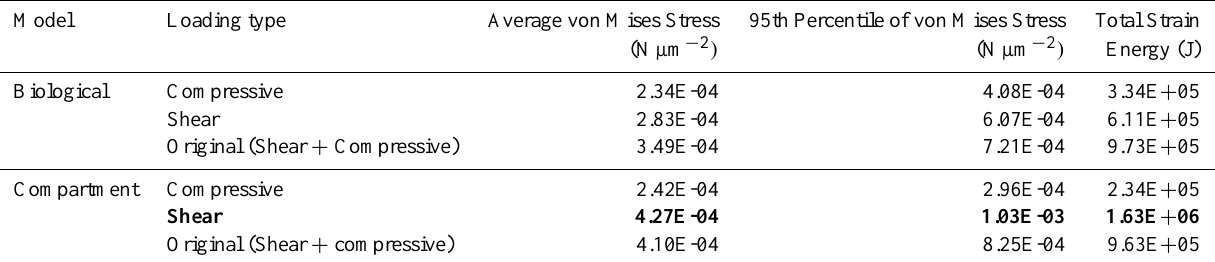
Figure 9. Comparison of all 3-D models. (a) The 3-D corridor model (b) the compartment model and (c) the biological model. Units = Pa. Table 3. Average von Mises stress, 95th percentile of von Mises stress and total strain energy for the different load types exerted on the biological, compartment and corridor models. Total strain energy for the biological model has been corrected for calcite volume (Eq. 2). The compartment model under the shear loading type is highlighted in bold to reiterate that the loading setup is different to the biological model under a shear loading